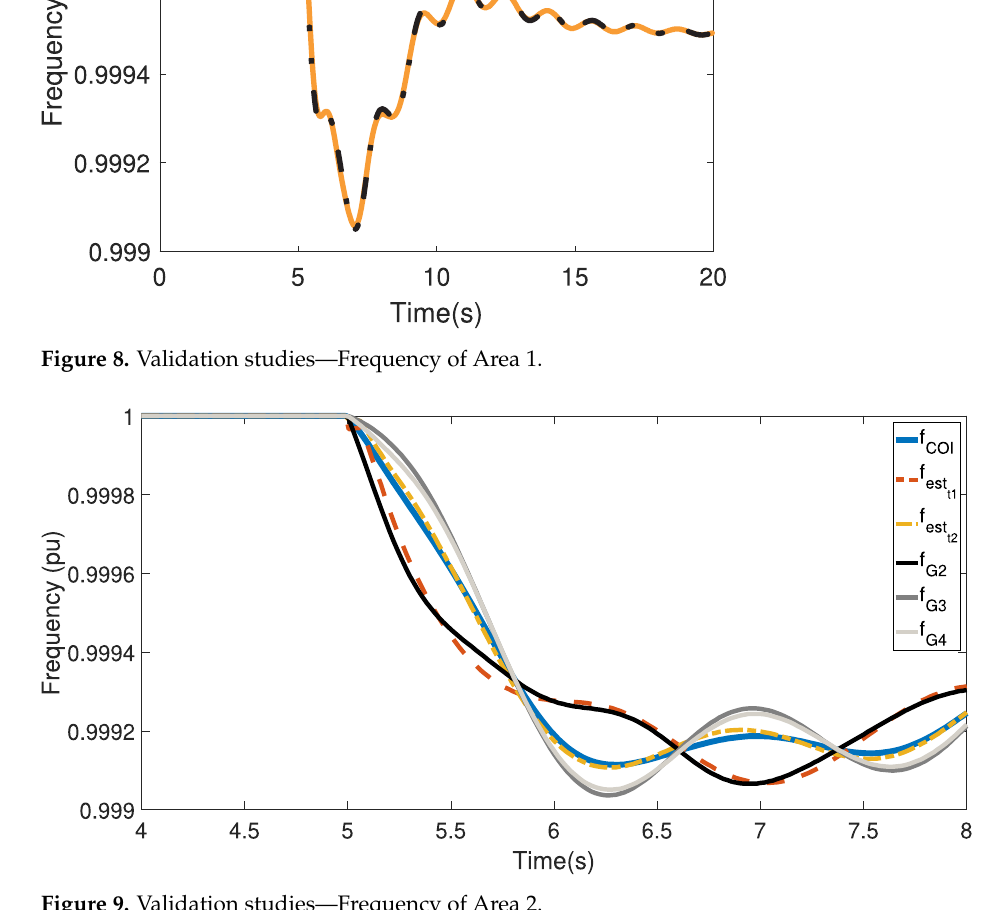
Figure 9. Validation studies—Frequency of Area